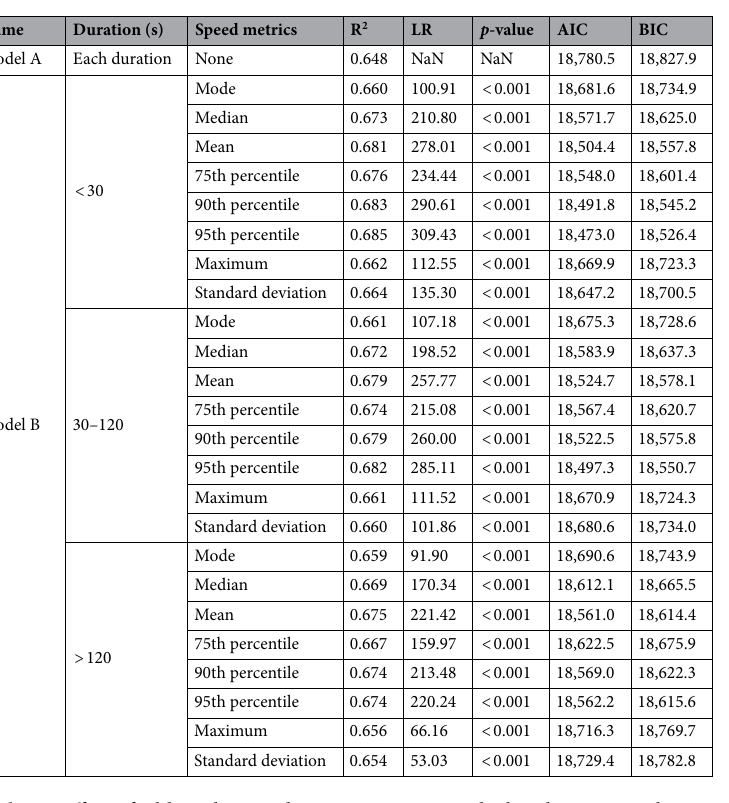
Table 3. Effect of adding the speed metrics to estimate the handgrip strength, CoLaus cohort, Lausanne, Switzerland, 2014–2017. Model A includes gender, age, BMI, and PA; model B consists of all variables from model A plus the variable of interest (the speed metric specified in each row). Models A and B were compared by likelihood ratio (LR) test. NaN the values which were not possible to be computed, AIC Akaike’s information criterion, BIC Bayesian information criterion.